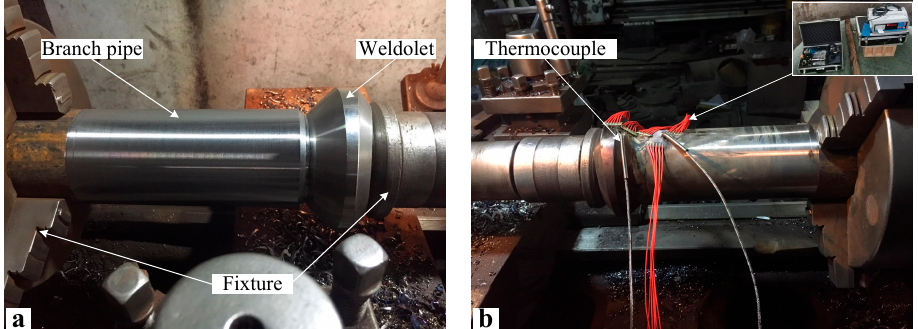
Figure 2. The welding experiment setup of the weldolet–branch pipe ( a ) before welding and ( b ) after welding. Table 1. Welding methods and parameters.